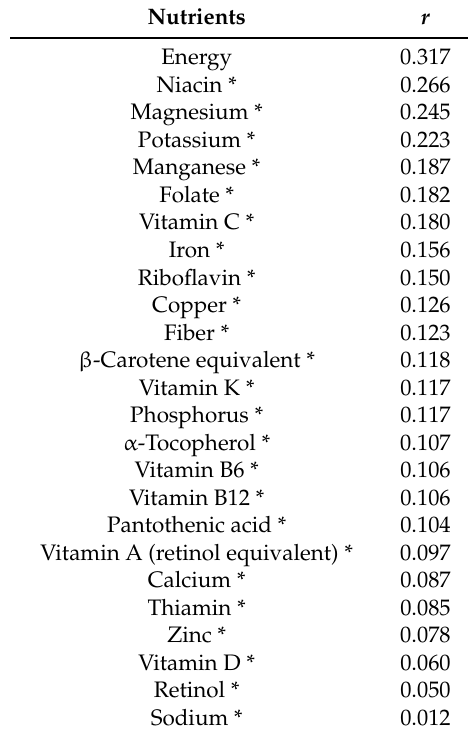
Table 4. Correlation coefficients of energy-adjusted micronutrient intakes with polyphenol intake. Nutrients r Energy 0.317 Niacin *